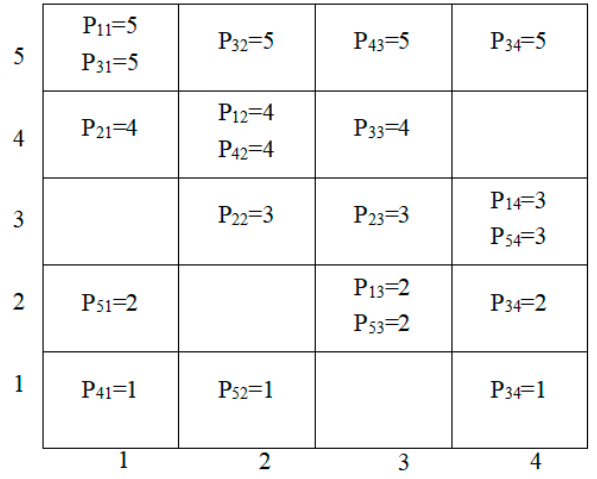
Figure 2. Pareto front in parallel cell coordinate system.